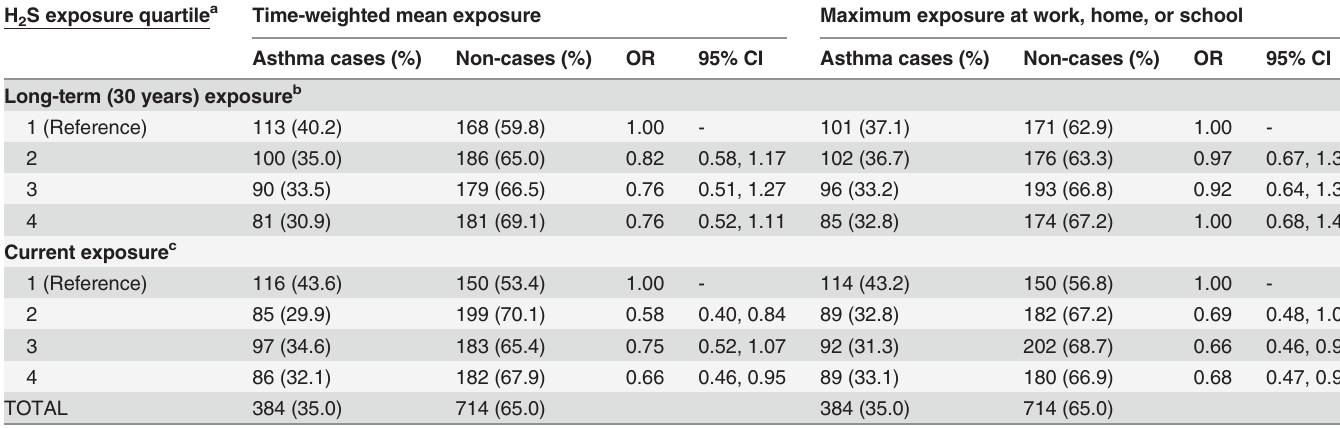
Table 6. Unconditional logistic regression analysis of asthma and both long-term (up to 30-years) and current H 2 S exposure metrics in Rotorua city residents, 2008 – 2010, limited to participants with satisfactory pre- and post-bronchodilator measurements (N = 1,098). H 2 S exposure quartile